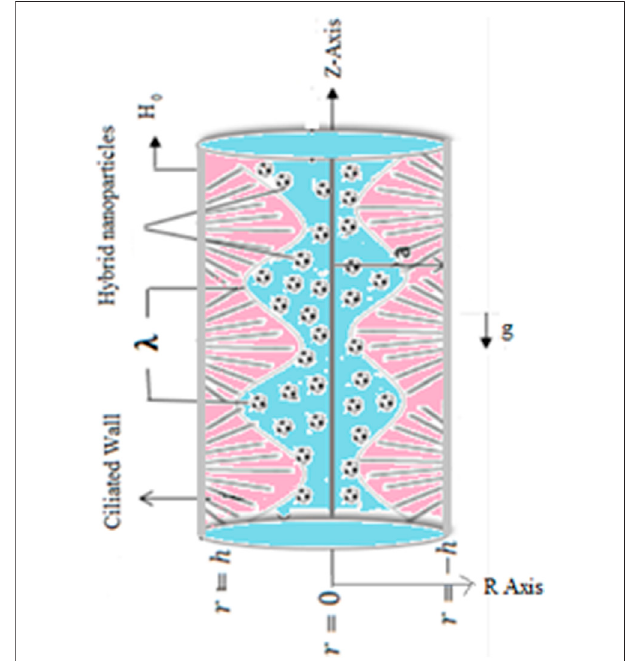
FIGURE 1 | Geometrical interpretation of the physical